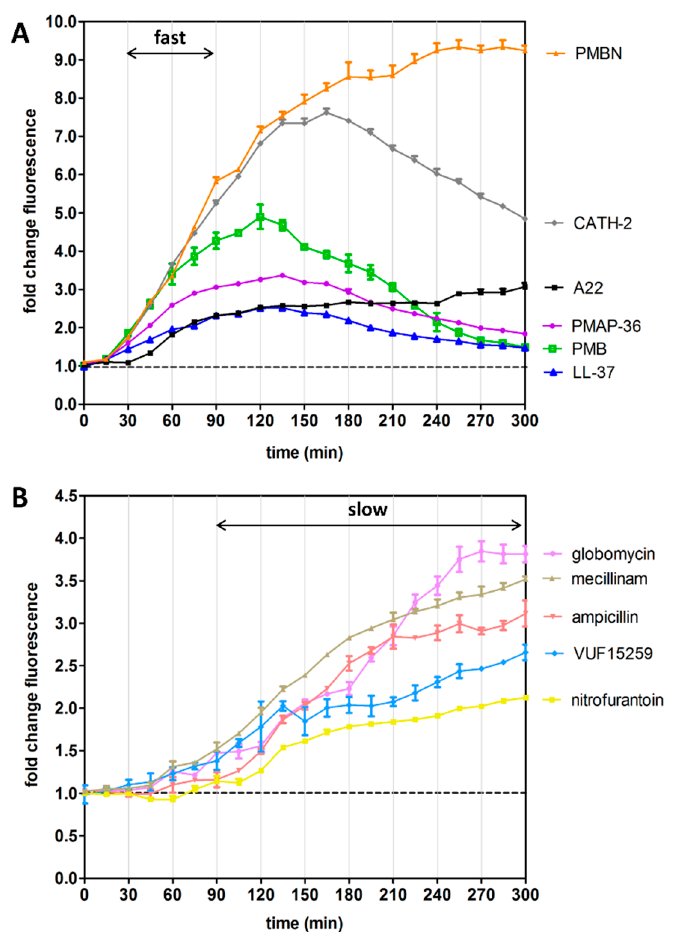
Figure 3. Real-time monitoring of Rcs stress activation in response to selected agents. The graph displays the kinetics of the Rcs response upon addition of the antibacterial agents that are listed in Table 1. E. coli TOP10F’ cells, harboring the P rprA -mNG reporter construct, were grown in a 96-well plate and exposed to 0.5 × MIC of the indicated agents. mNG fluorescence was measured in time, corrected for growth (OD 600 ) and plotted as fold-change of signal compared to untreated cells (set to 1, dashed line), with agents that show ( A ) a fast response and ( B ) a slow response, as indicated. Error bars represent the standard deviation of duplicate samples. The figure shows a representative example of three independent experiments.